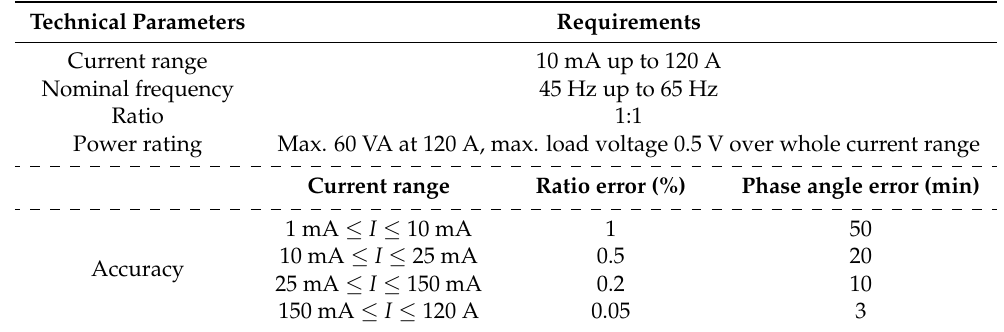
Table 1. Technical requirements, adapted according to